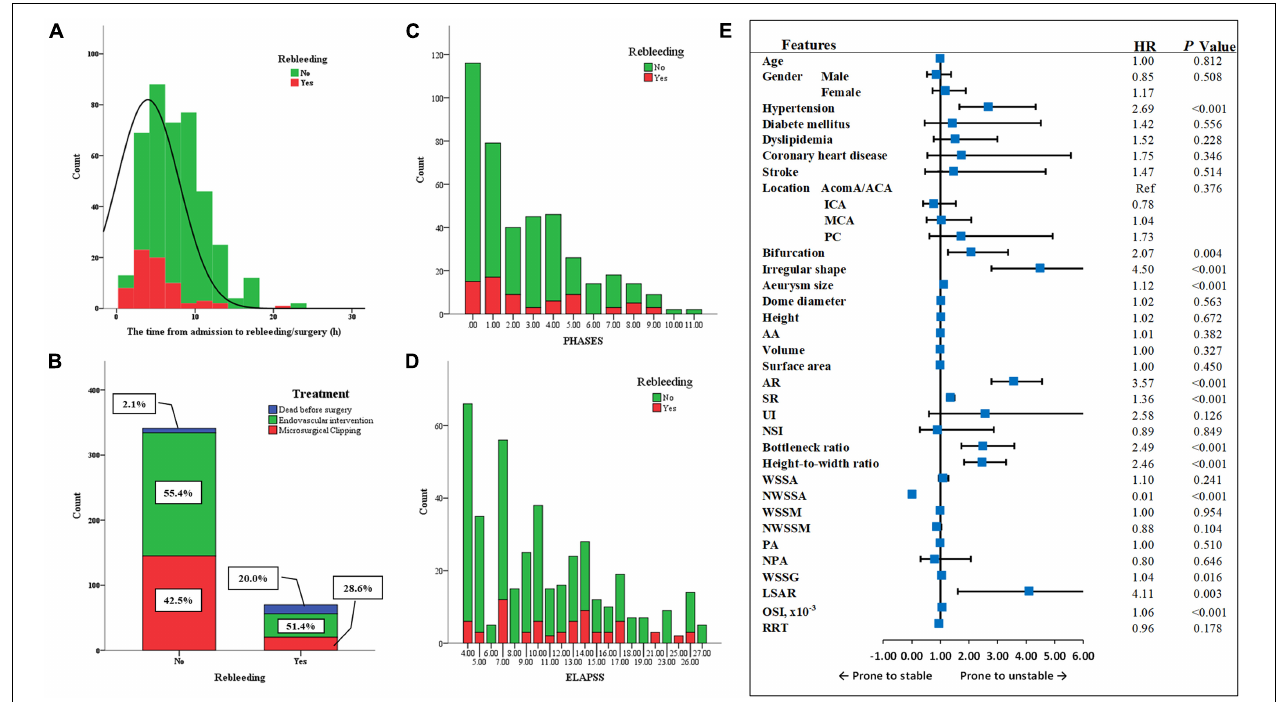
FIGURE 3 | The factors related to the rebleeding after admission. (A) The average time from admission to the rebleeding was 4.4 ± 4.7 h. (B) 54.7% patients received endovascular intervention, and 40.2% patients received microsurgical clipping, whereas 5.1% died before the surgery, of which 66.7% patients underwent rebleeding after the admission. (C,D) The PHASES score and ELAPSS score were presented here. (E) The forest plot summarized the result of univariate Cox regression analysis. MCA, middle cerebral artery; ICA, internal carotid artery; AcomA, anterior communicating artery; ACA, anterior cerebral artery; PC, posterior circulation; AA, aneurysm inclination angle; AR, aspect ratio; SR, size ratio; UI, undulation index; NSI, non-sphericity index; WSSA, wall shear stress average; NWSSA, normalized wall shear stress average; WSSM, wall shear stress maximum; NWSSM, normalized wall shear stress maximum; PA, pressure average; NPA, normalized pressure average; WSSG, wall shear stress gradient; LSAR, low shear area ratio; OSI, oscillatory shear index; RRT, relative resident time; Ref, reference; HR, hazard ratio.